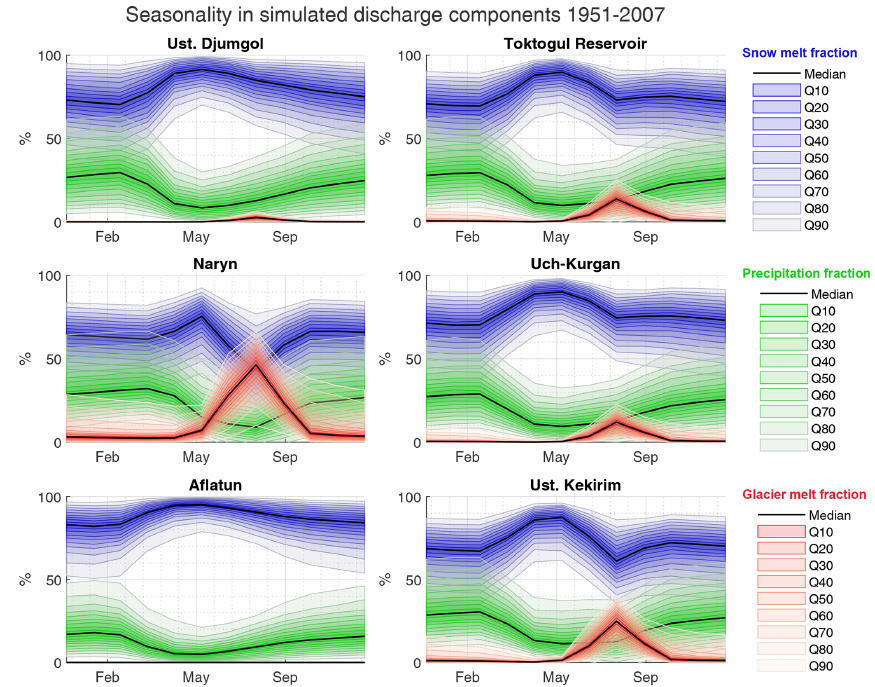
Figure 12. Monthly simulated runoff components averaged over the period 1951–2007 for the top 0.5% calibration simulations ( n = 751). The coloured envelope shows the 5th–95th percentile